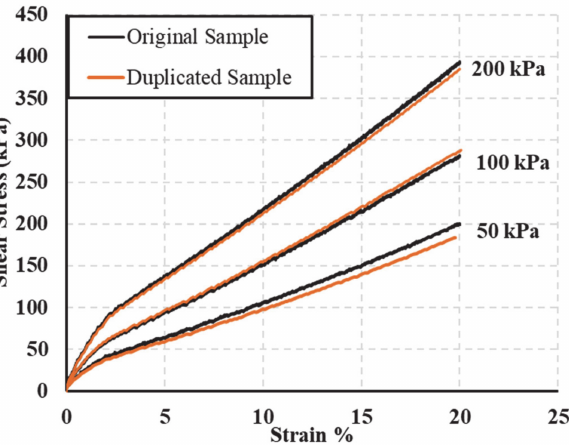
Figure 5. Deviatoric stress vs. strain curves for the duplicated tests for the 25.4 mm